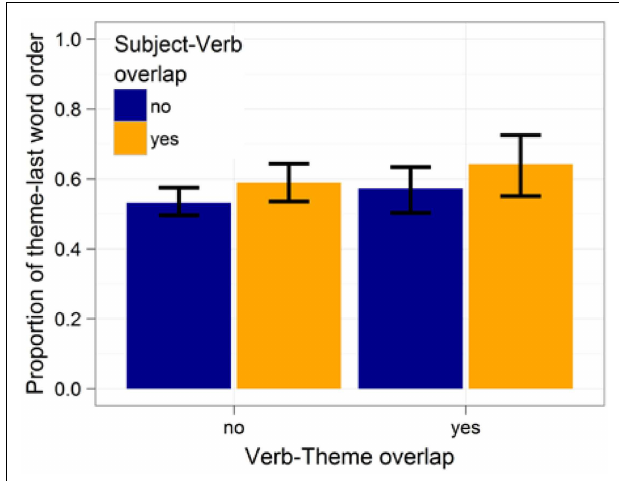
FIGURE 2 | Effects of subject-verb and verb-theme overlap on constituent order preferences for participants that produce each of the two possible constituent orders at least 10% of the time. Proportions are out of 1256 cases. Error bars give 95% confidence